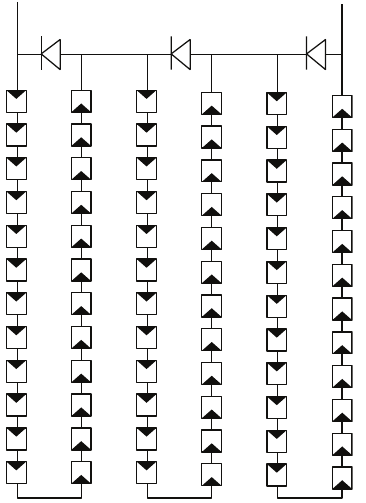
Figure 2: Circuit diagram of the solar module with 72